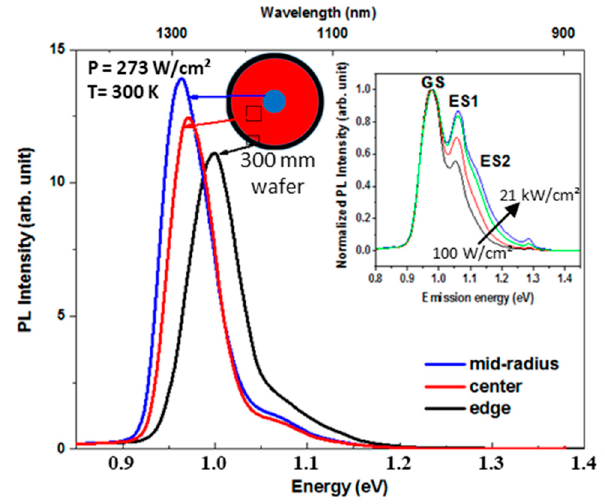
Figure 5. Room temperature PL spectra from InAs QDs grown on GaAs/Ge/Si structure at the center, at the mid ‐ radius and the edge of the wafer with a power density of 273 W/cm 2 . The inset shows the evolution of the normalized μ PL spectra as function of the increased optical power density from 100 W/cm 2 (black line) to 21 kW/cm 2 (blue line).